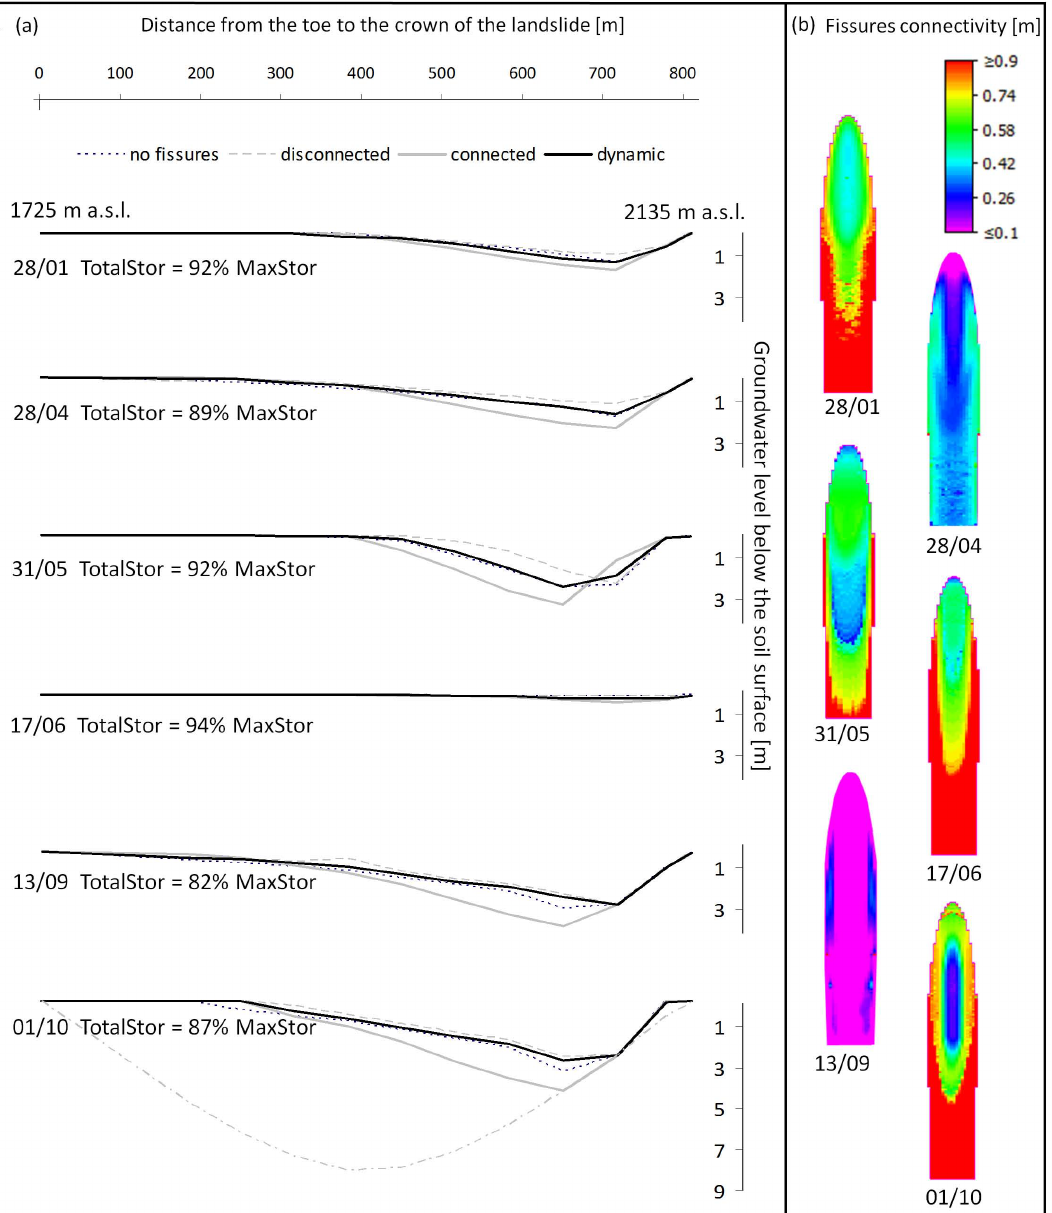
Fig. 8. (a) Modelled groundwater levels along the landslide profile (major axes of the ellipse); x-axis represents the distance from the toe of the landslide (0m) to the crown (800m). (b) The distribution of fissure connectivity over the landslide area, corresponding to these groundwater levels and observed total storages. The light grey line, present in the last profile of sub-figure (a) , represents the bedrock depth. Please note the exaggeration of the vertical